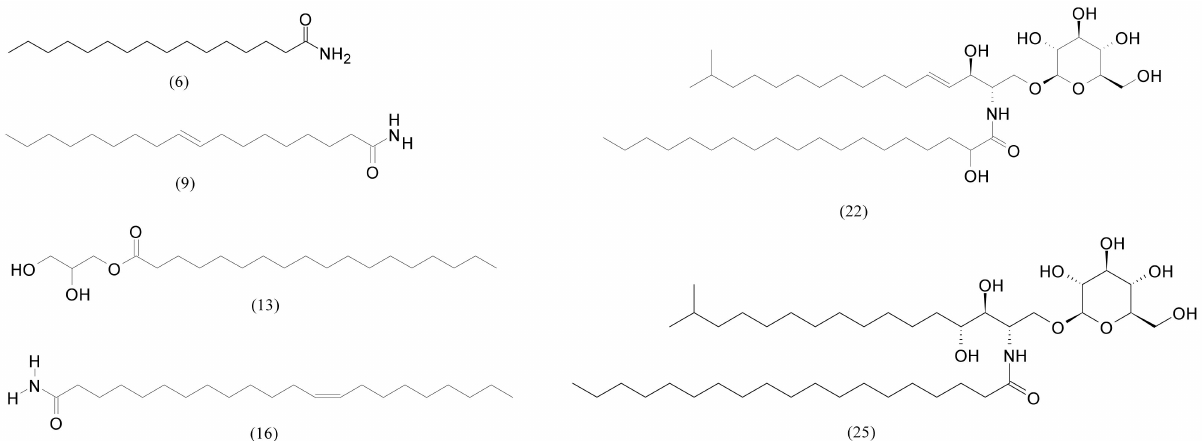
Figure 4. Molecular structures of the major fatty acid derivatives from Table 3, where the numbers correspond to Table 3.